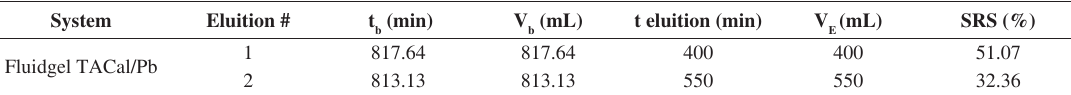
Table 5. Balance recovered water removal - elution of lead.